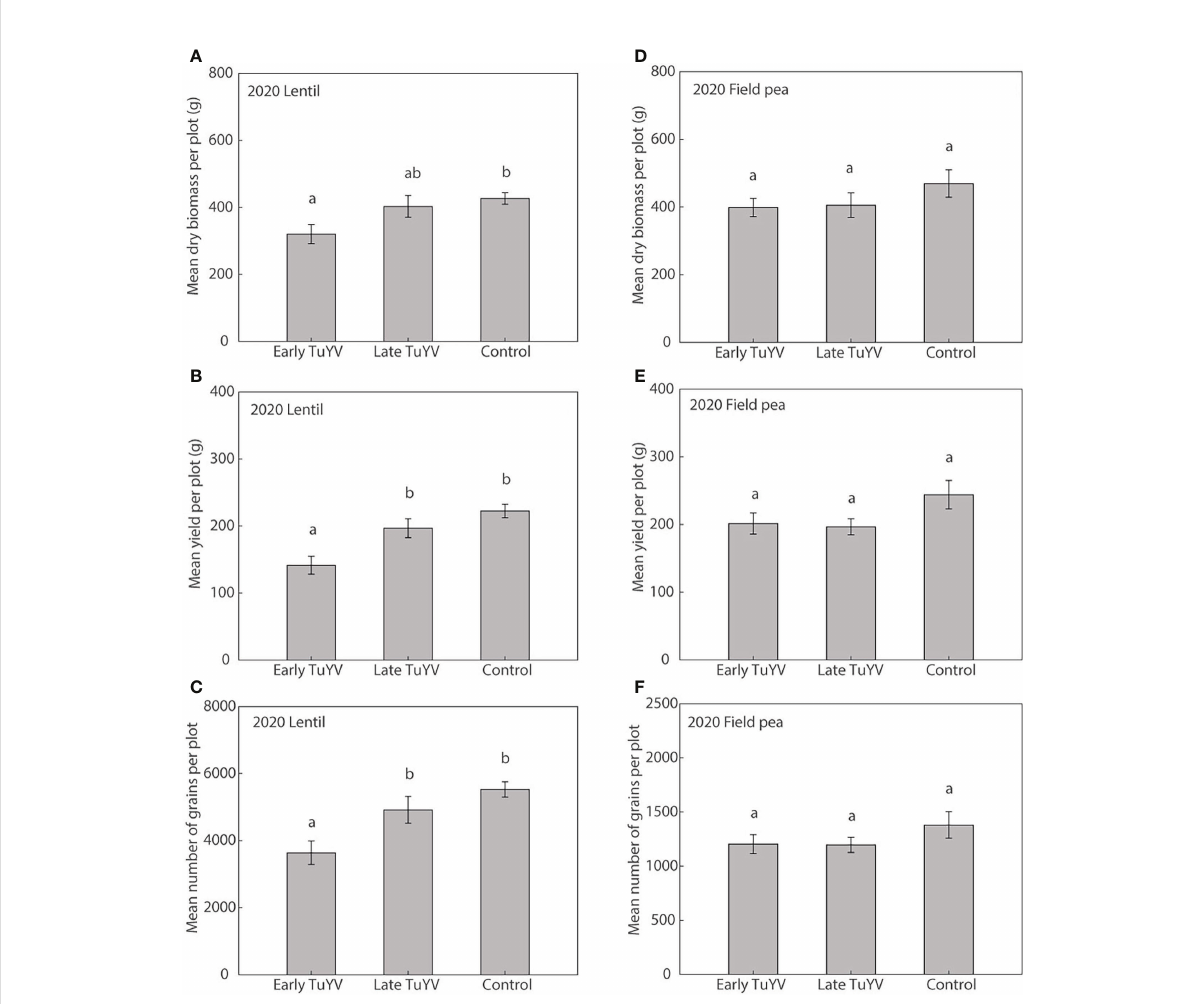
FIGURE 5 The effect of early and late turnip yellows virus (TuYV) infection on dry plant biomass (A, D) , grain yield (B, E) and number of grains (C, F) of lentil (left) and fi eld pea (right) in fi eld experiments (2020) in south-eastern Australia. Standard errors are represented by error bars; means with different letters are signi fi cantly different at p < 0.05 according to